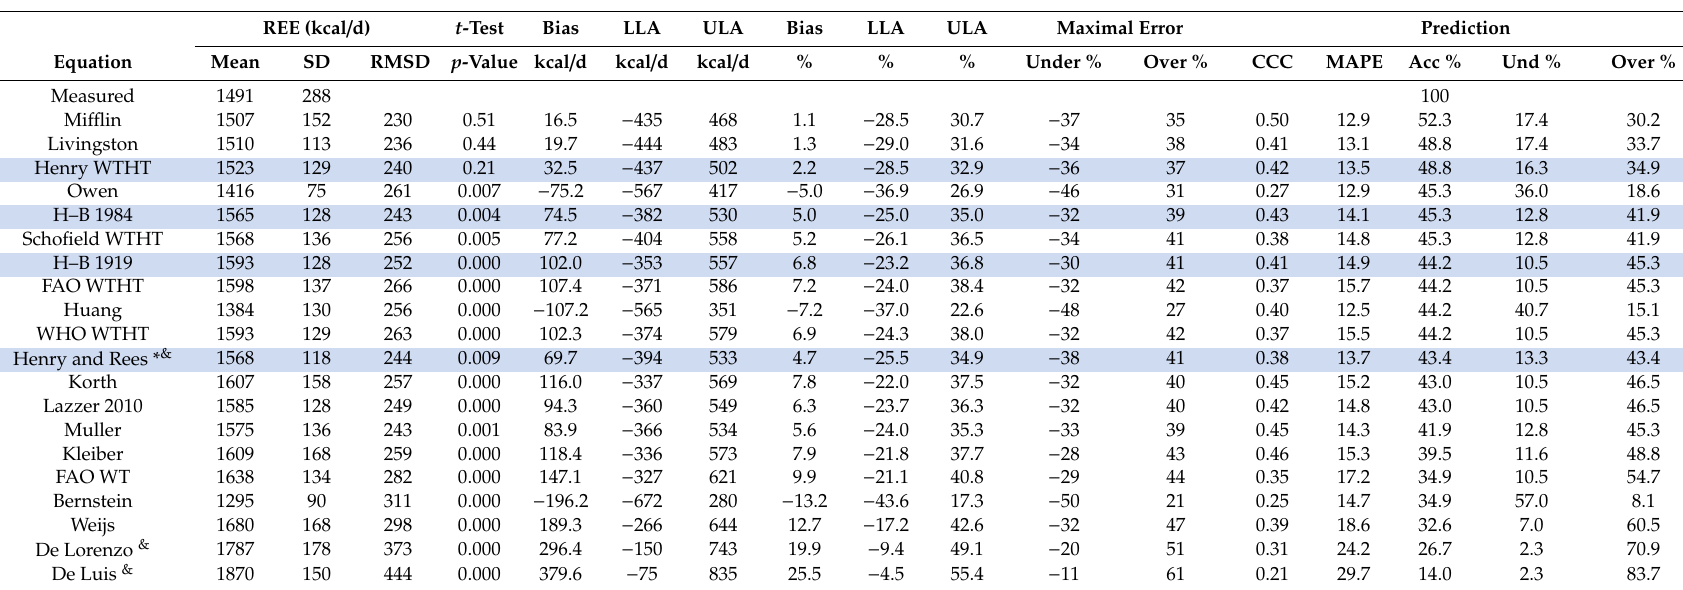
Table 5. Assessment of resting energy prediction equations in overweight and obese women ( n = 86) from the population of Gran